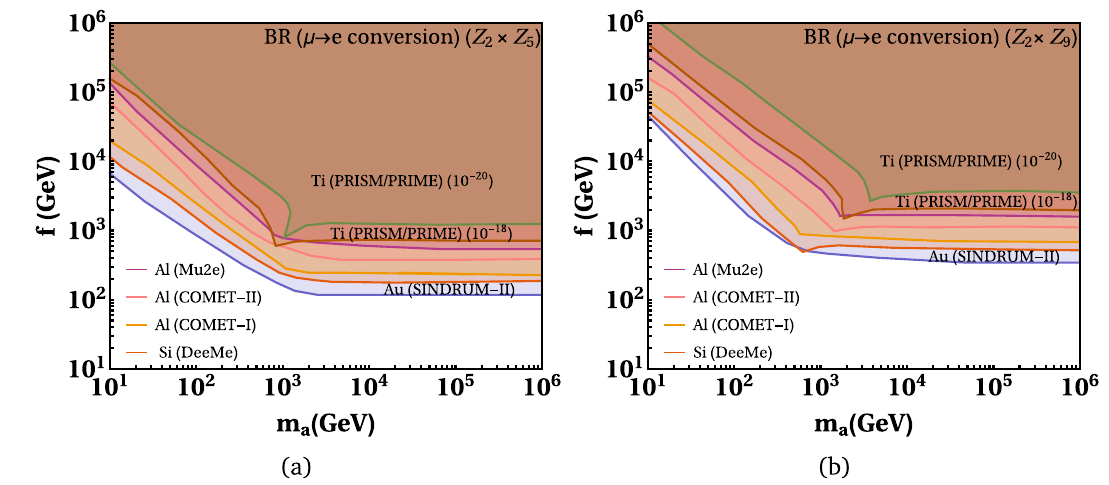
minimal ( Z 2 × Z 5 ) model. Similar allowed parameter space for the non-minimal ( Z 2 × Z 9 ) model is shown in the right panel